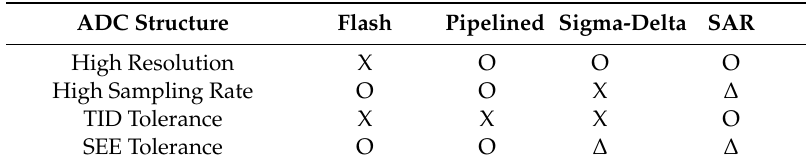
Table 1. Performance comparison of various ADC structures against total ionizing dose (TID) and single event e ff ect